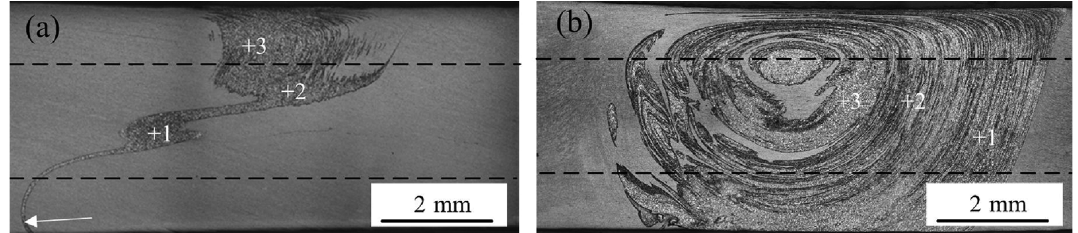
Figure 8: Typical morphologies of cross section of VCFSW joints at different welding speeds: (a) 200 mm/min and (b) 50 mm/min.